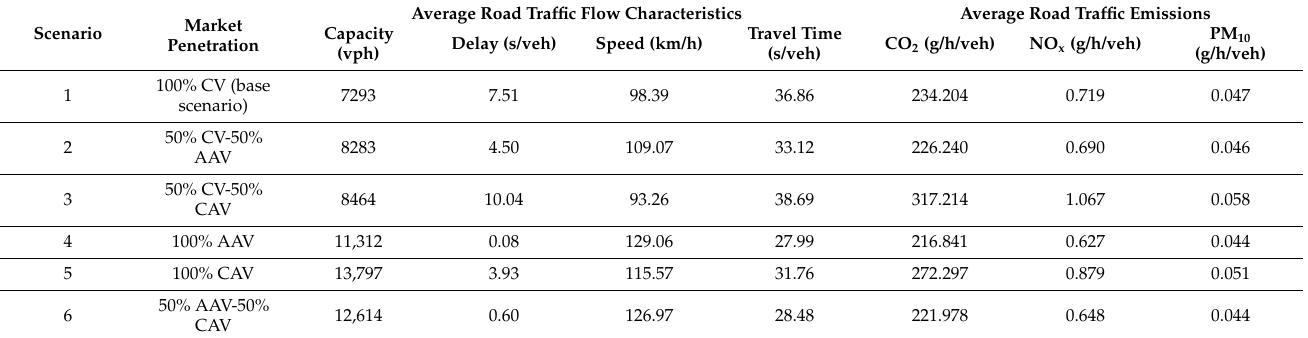
Table 2. Traffic flow characteristics and traffic emissions for basic freeway